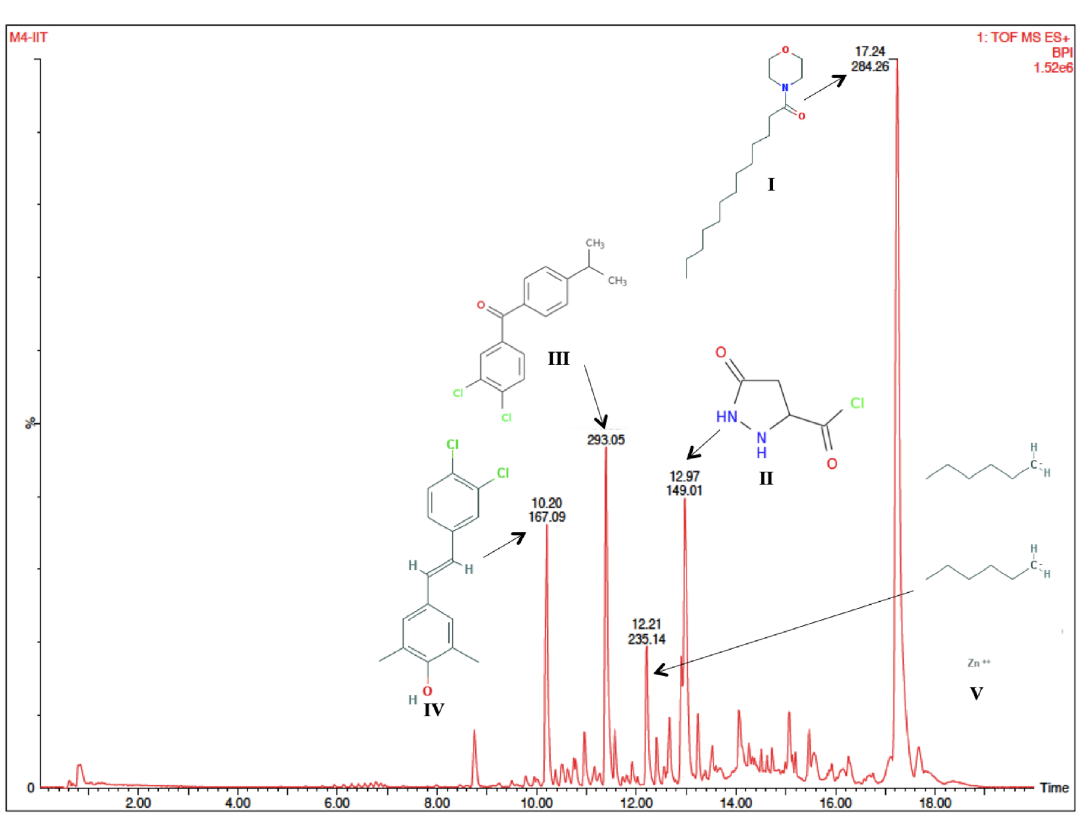
Figure 5. UPLC-MS chromatogram of bioactive fraction of ethyl acetate extract of Trichoderma harzianum 3928 with retention time (min) on x-axis and area (%) on y-axis with chemical structure of major five compounds. For name of the compound refer Table